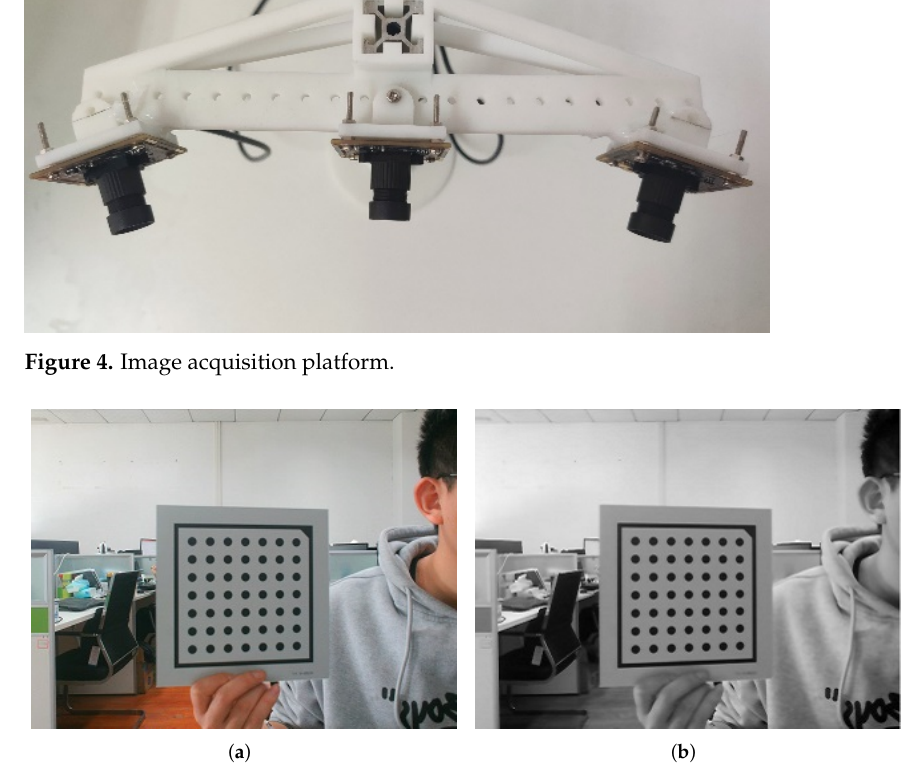
Figure 5. Image preprocessing. ( a ) The original image, ( b )